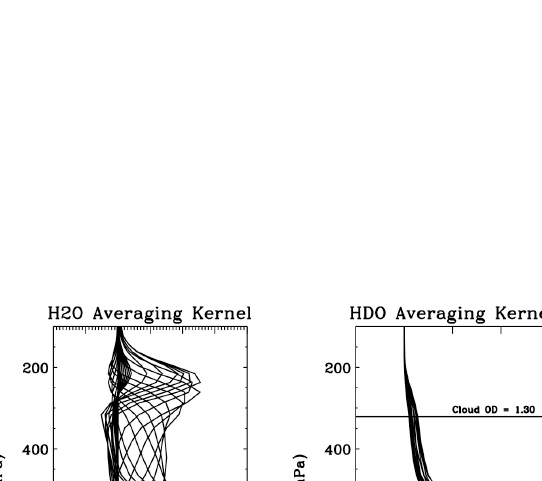
Fig. A7. Same as Fig. A2 but for 5 November 2008. Figure A7: Same as Figure A2 but for November 5 2008.